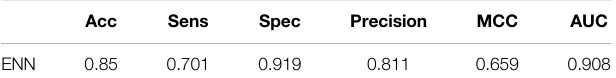
Frontiers in Genetics |